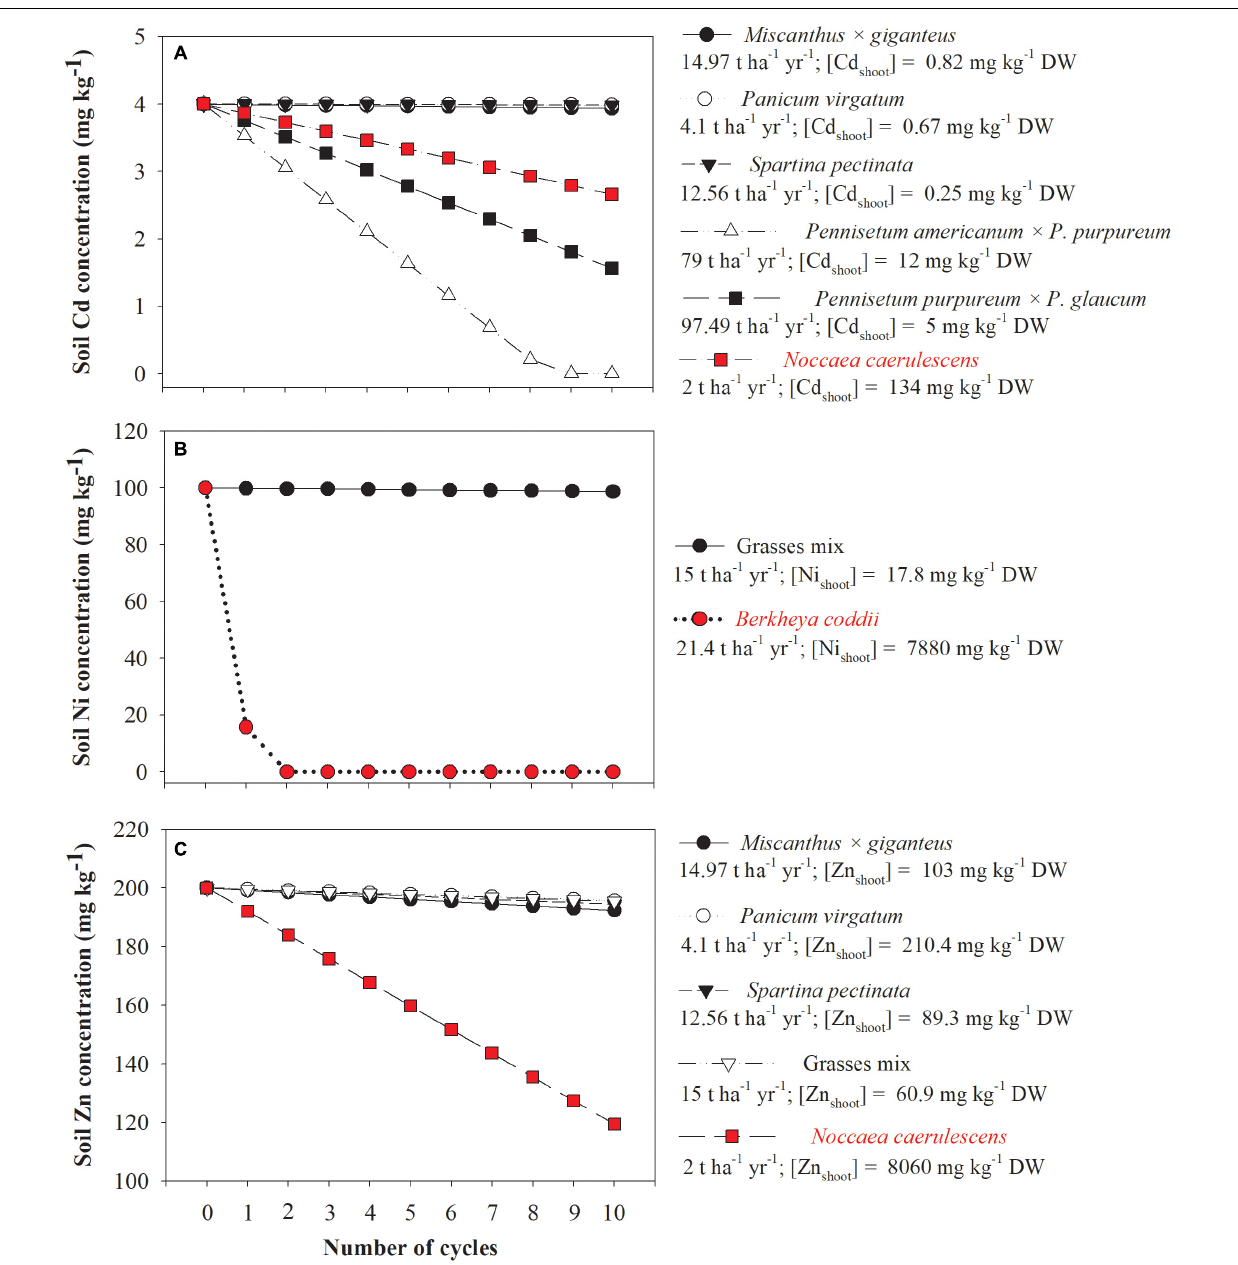
FIGURE 5 | Theoretical reduction on cadmium (Cd, A ), nickel (Ni, B ), and zinc (Zn, C ) concentrations by the cultivation of grasses and known hyperaccumulator plants (highlighted in red color), in a mildly contaminated soil, according to the number of cycles of cultivation (in this specific case, one cycle corresponds to 1 year of cultivation). The assumptions made were: (i) the total soil metal concentration decreases linearly due to a constant yearly extraction, (ii) the contamination and rooting depth are 0.2 m, and (iii) soil density is 1 kg dm − 3 . Grasses mix = Festuca arundinacea , Festuca rubra , Lolium perenne, and Poa pratensis . The data of the biomass yield and metals concentration used to plot this figure were extracted from Robinson et al. (1997); Zhang et al. (2014), Kitczak et al. (2016); Jacobs et al. (2018), Rusinowski et al. (2019), and Zhou et al.